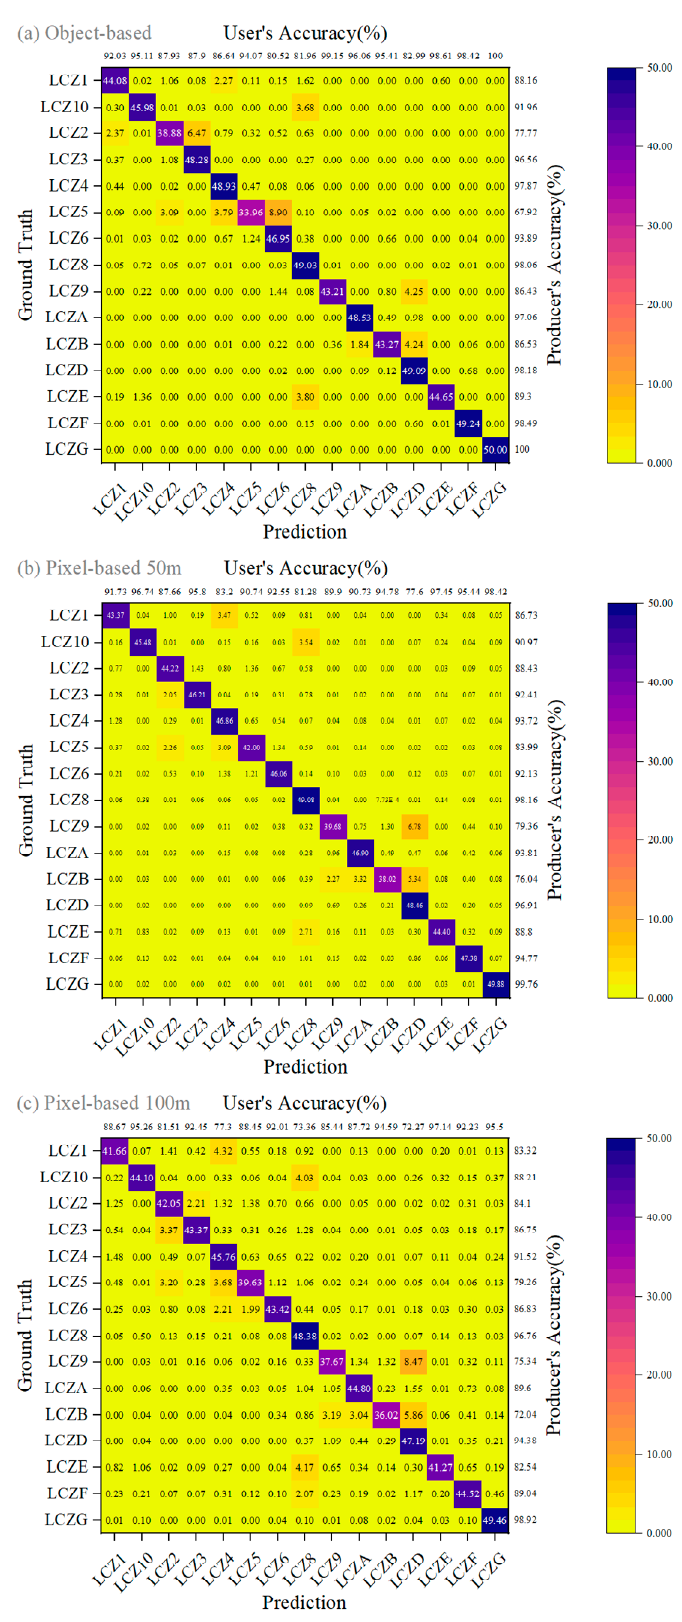
Figure 9. Confusion matrices of three schemes. Each confusion matrix is the accumulation of 50 normalized confusion matrices where the original elements have been divided by the row total. ( a – c ) are the confusion matrices of object-based, pixel-based in 50 m, pixel-based in 100 m respec- tively.